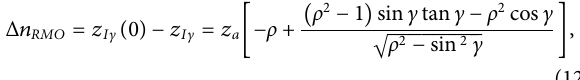
where the subscript s refers to the source-side rays and the subscript r refers to the receiver-side rays; t s 1 and t s 2 represent the time of forward-propagating rays from virtual source to re fl ector-1, from re fl ector-1 to re fl ector-2; t r 1 and t r 2 represent the time of backward- propagating rays from receiver side to re fl ector-1, from re fl ector-1 to re fl ector-2.